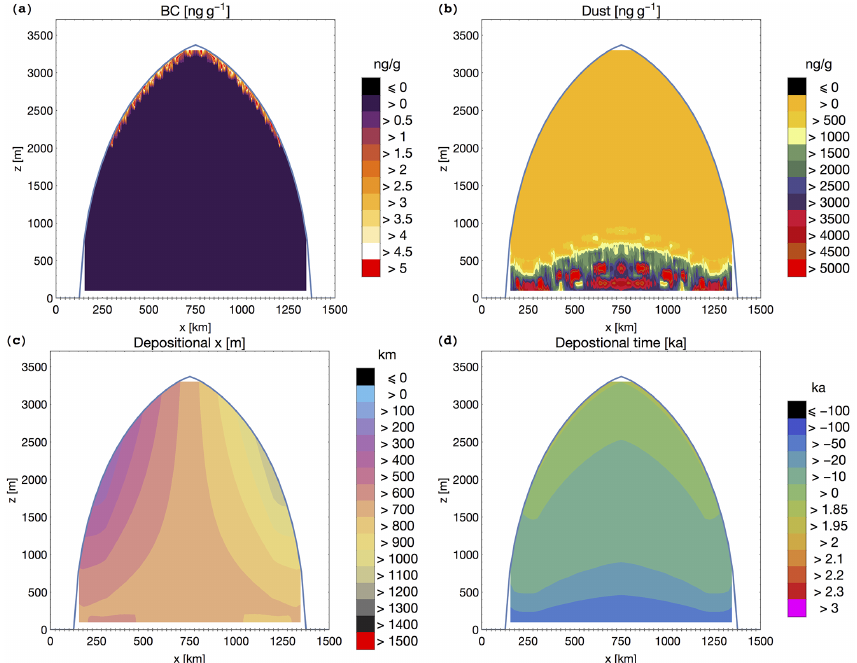
Figure 5. Cross section of the spin-up ice sheet in the year 2000: (a) englacial black carbon concentration, (b) dust concentration, (c) depo- sitional x (provenance) and (d) depositional time (where 2ka is the year 2000 AD).